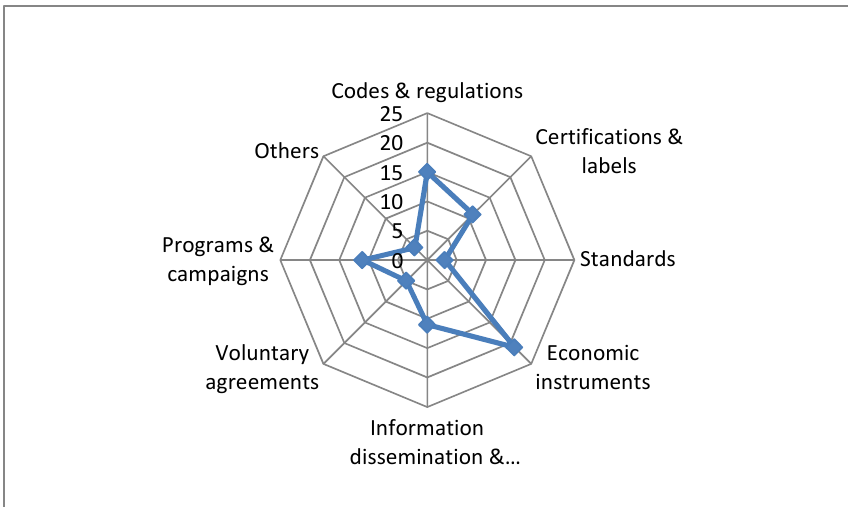
Figure 4. Number of papers dealing with the primary topics.